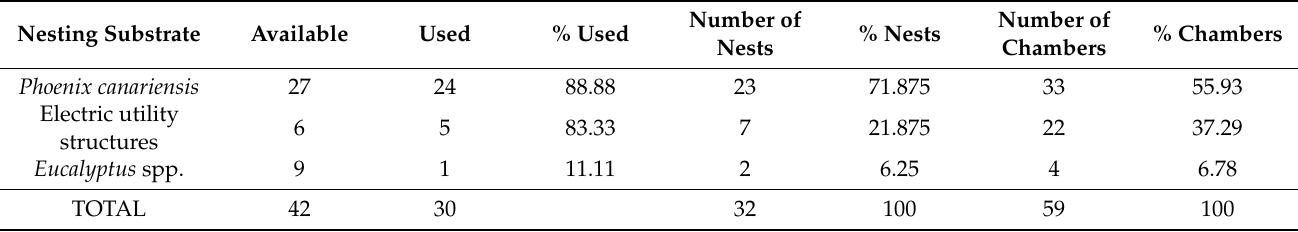
Table 1. Nesting substrates used by the Monk Parakeet in the study area in 2017.